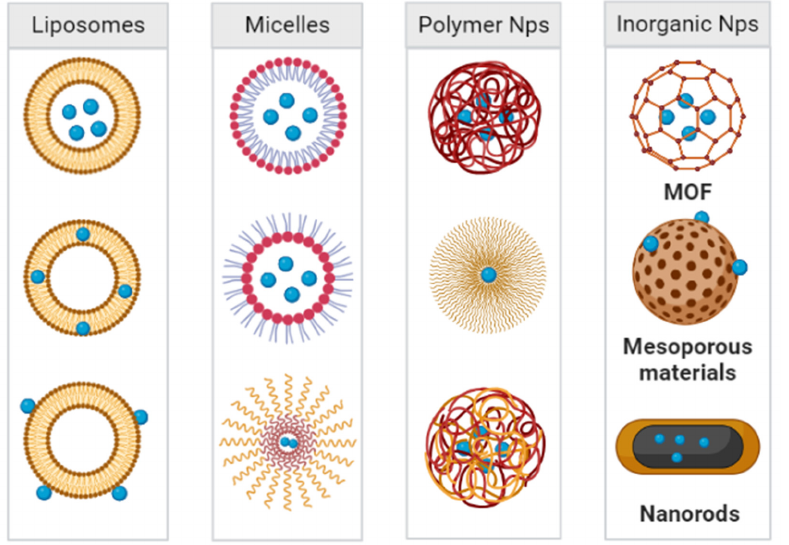
Figure 7. Nanoparticle systems currently under study for the delivery of antibacterial agents in the treatment of pneumonia.